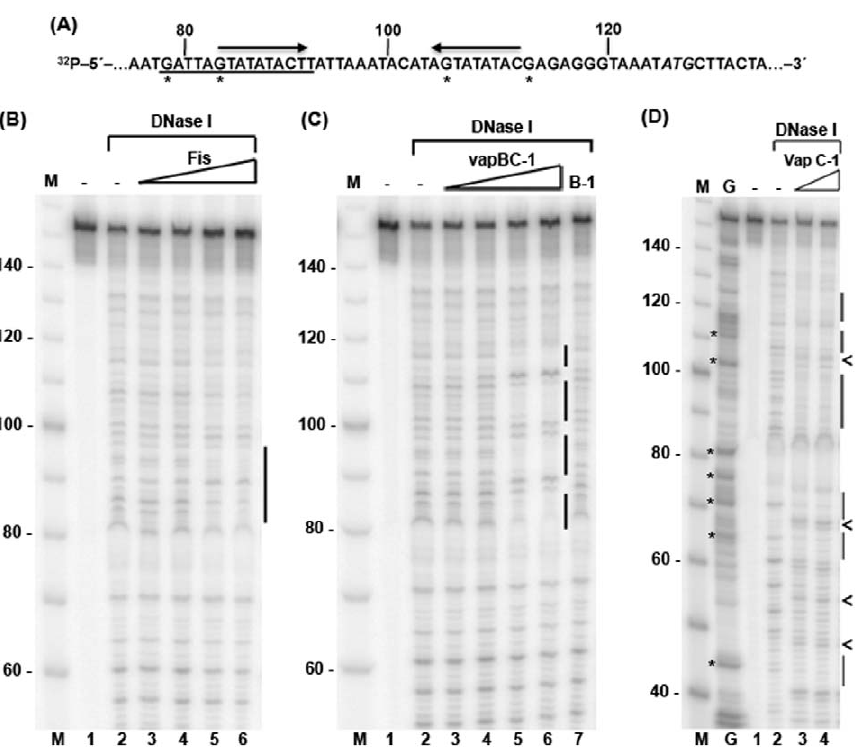
Figure 3. DNase I protection of the vapBC-1 locus control region by Fis and Vap proteins. (A) The 32 P-labeled sense strand of 153 bp DNA substrate containing vapB-1 TIR and upstream sequence in the vapBC-1 locus control region, is shown with numbers indicating the distance from the 5 9 -labeled end. The putative Fis site ( underline ), inverted repeat regions ( arrows ), vapB-1 translation start ATG ( italics ), and G cleavage products ( * ) seen in (D, lane G ) are noted. On each gel shown, a 10 bp DNA ladder ( lane M ), 153 bp substrate without protein ( lane 1 ), and DNase I digest of the substrate ( lane 2 ) are indicated. Gels show DNase I cleavage products from samples containing: (B) a Fis:DNA molar ratio of 2:1, 7.5:1, 15:1, or 30:1 ( lanes 3–6 ), (C) a VapBC-1:DNA molar ratio of 2:1, 7.5:1, 15:1, or 30:1 ( lanes 3–6 ) or 40:1 VapB-1:DNA ( lane 7 ), and (D) VapC-1:DNA molar ratio of 40:1 or 80:1 ( lanes 3 and 4 ). Vertical bars indicate the DNase I footprint from protein binding. Arrows ( , ) in panel D indicate DNase I hypersensitive sites. The gels each represent one of two independent experiments.